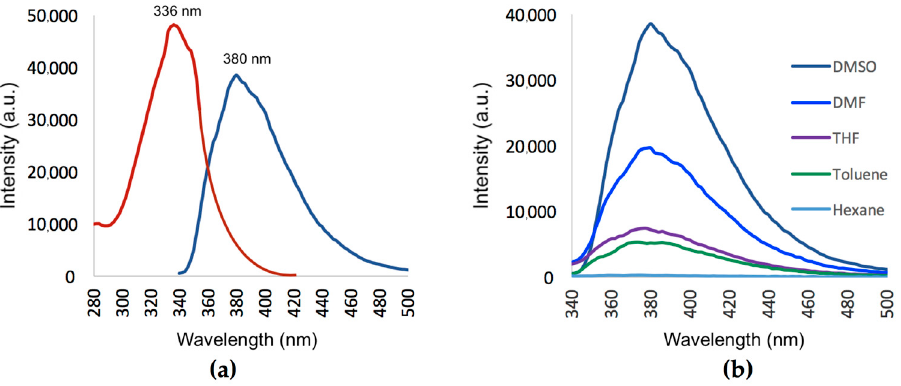
Figure 8. ( a ) Excitation and emission spectra of compound 1 . ( b ) Emission spectra of compound 1 showing the effect of different aprotic solvents of varying polarities.